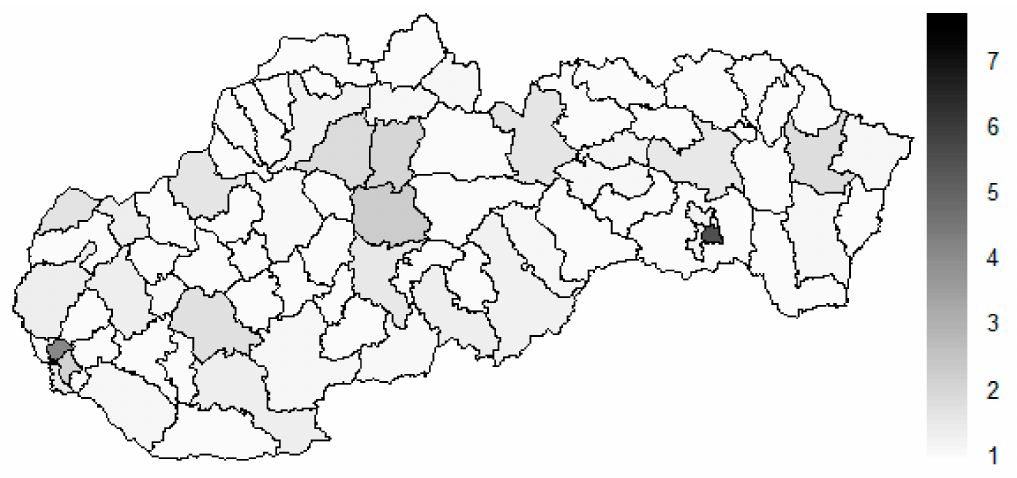
Figure 8. Medical equipment similarity map of the districts in the year 2015. Source: own elaboration by the authors.